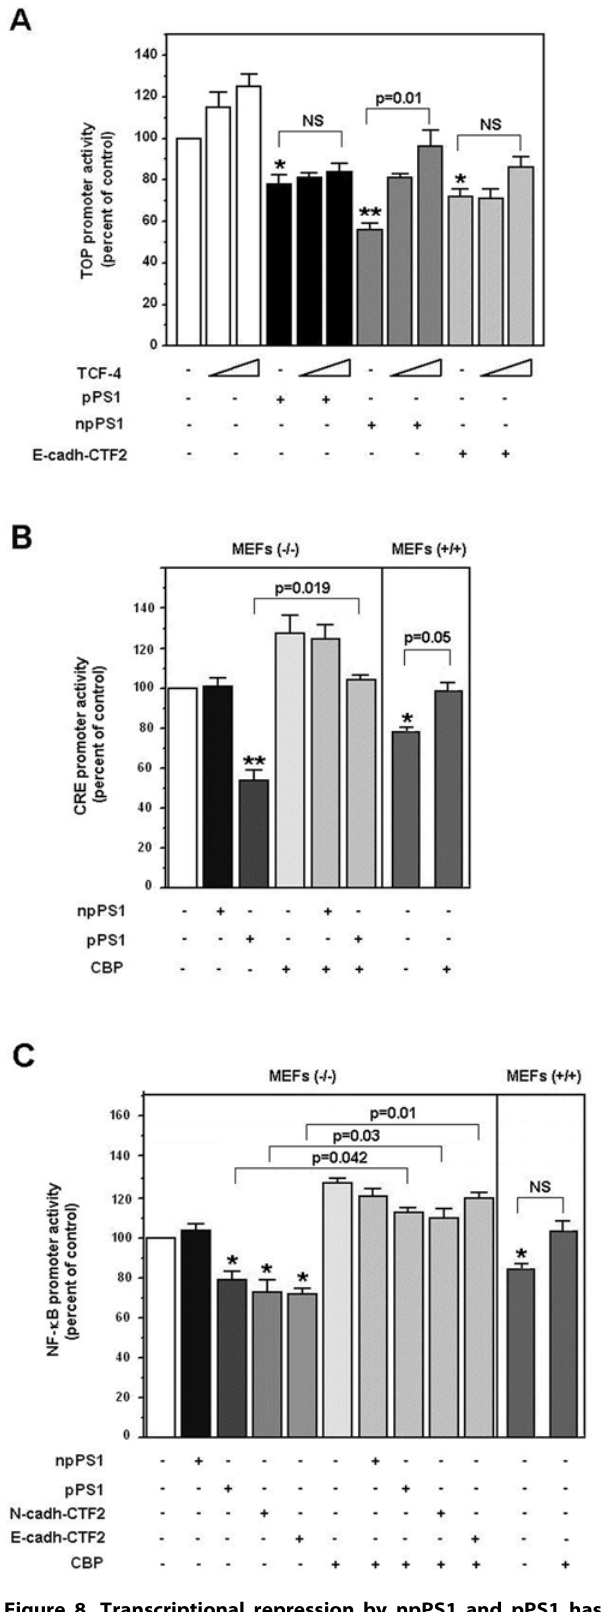
Figure 8. Transcriptional repression by npPS1 and pPS1 has different selectivity and requirements. (A) MEF PS ( 2 / 2 ) cells were cotransfected with pcDNA3.1-Tcf-4 (150 and 300 ng), pcDNA3.1- PS1 (pPS1), pcDNA3.1- Myc/His -PS1 (npPS1), pcEGFPC1-E-cadh-CTF2